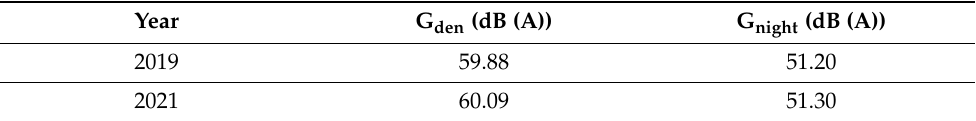
Table 1. G den and G night for Piombino in 2019 and 2021. Year G den (dB